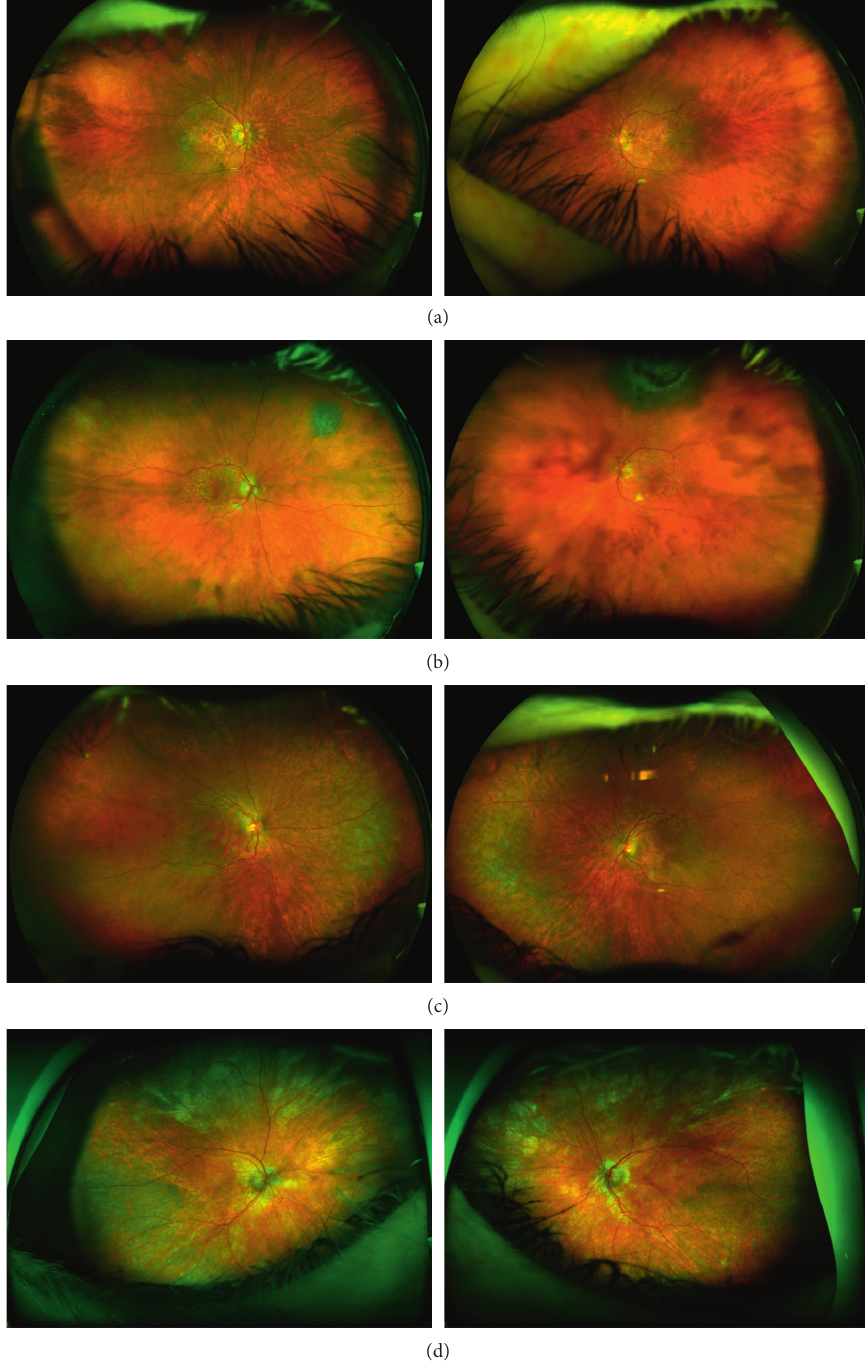
Figure 2: Ultrawidefield color fundus imaging of the retina in patient 1 (a), patient 2 (b), patient 3 (c), and patient 4 (d) demonstrates areas of macular atrophy and subtle pigmentary changes in both eyes. Patient 1 has a nevus in the right eye nasally, and patient 2 has a nevus in the right eye superonasally and a choroidal melanoma in the left eye superiorly. Patient 3 has reticular degeneration in the peripheral retina in both